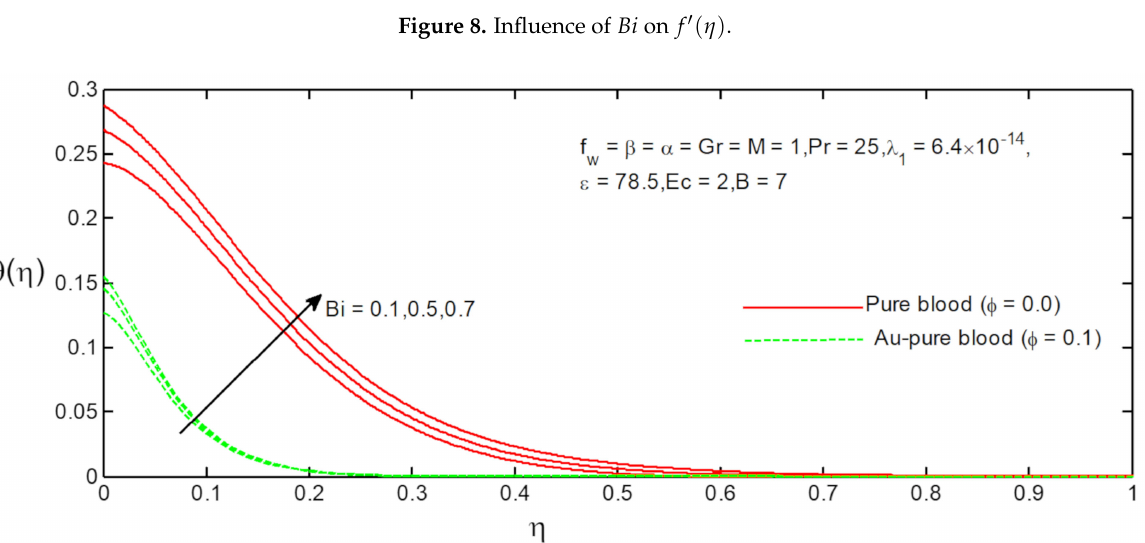
Figure 8. Influence of Bi on f (cid:48) ( η ) .